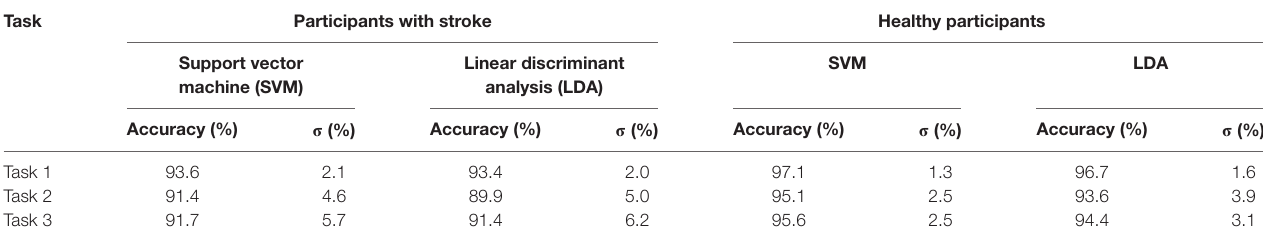
TaBle 1 | Average classification accuracy for participants with stroke, and healthy participants, for each task using the RBF-SVM and LDA